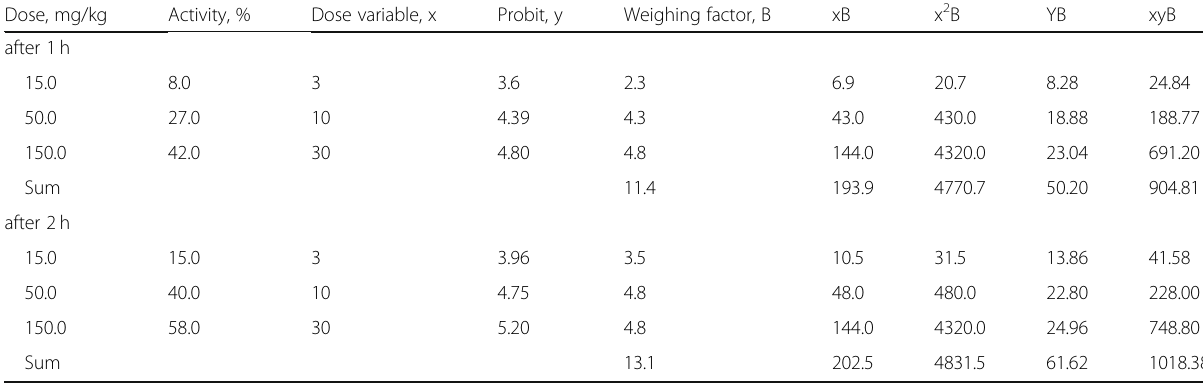
Table 1 Dose values and activity level for determining ED 50 of dry combined extract BNO 1016 in rats according to anti- inflammatory activity by Probit